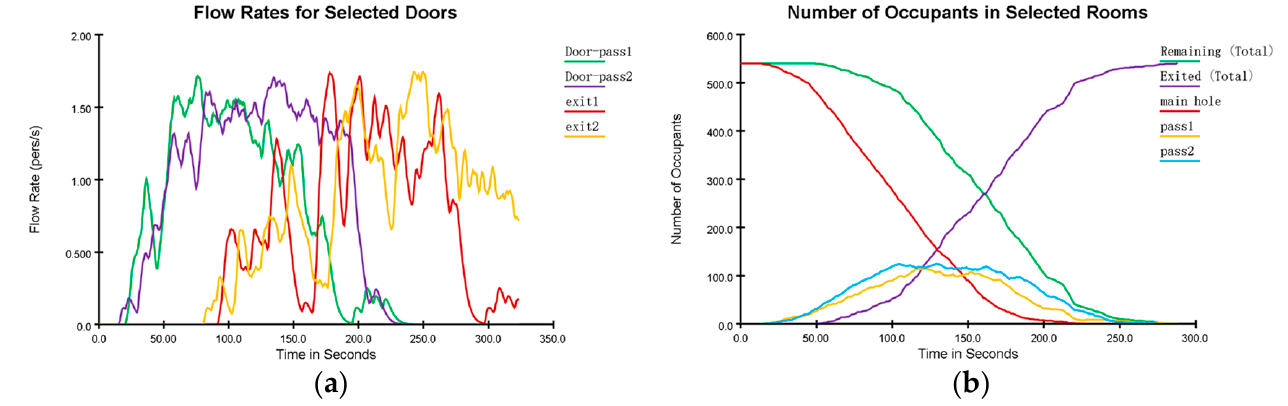
Figure 18. Results of evacuation simulation of working condition #2: ( a ) number of people passing through doors and exits; ( b ) time and number of people in di ff erent areas.